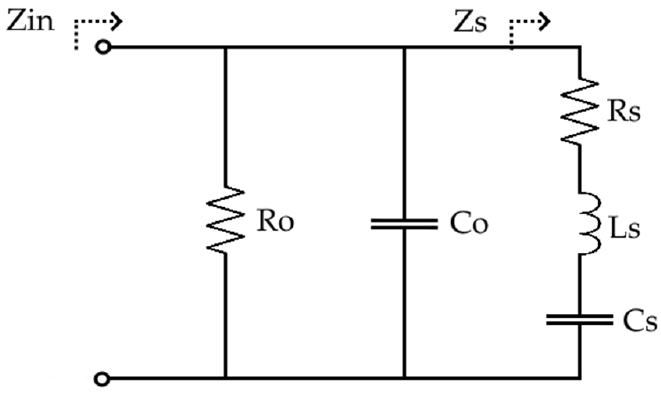
Figure 3. Mason model equivalent circuit for PVDF.